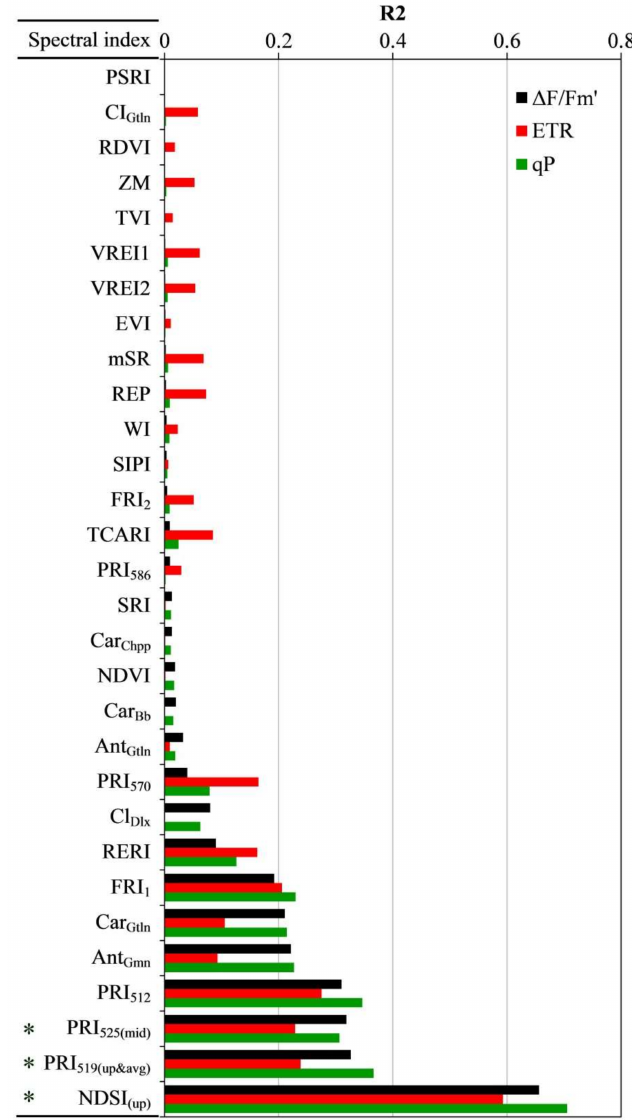
Figure 8. Comparison of correlations between the spectral indices and the physiological parameters. * denotes the indices proposed in this